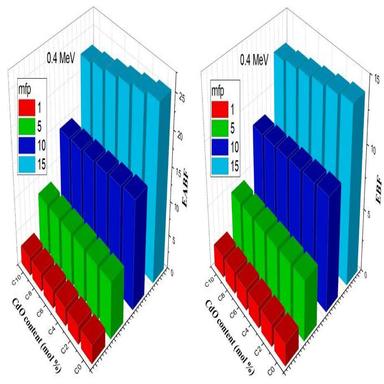
Variation of exposure buildup factor (EBF) energy absorption buildup factor (EABF) values against 0.4 MeV energy at 1, 5, 10 and 15 mfp.